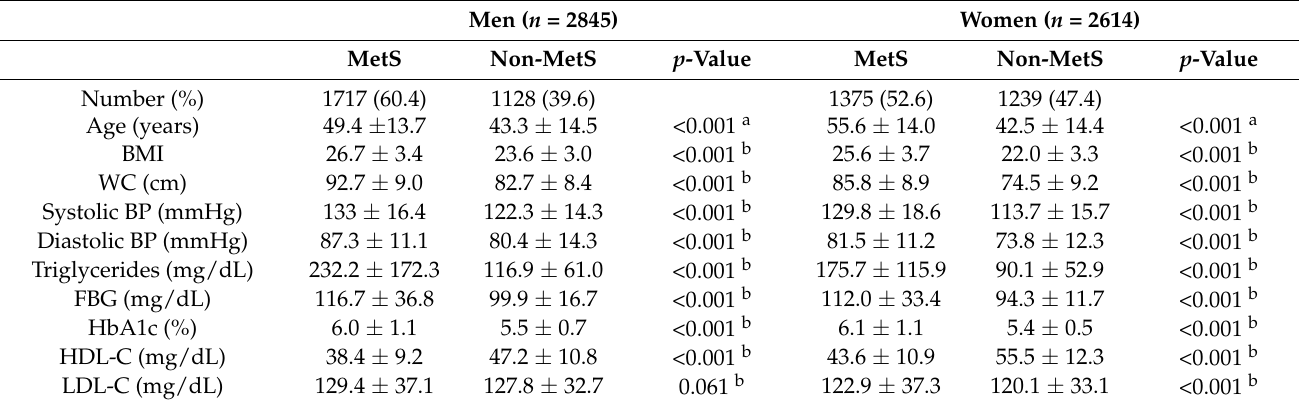
Table 2. Characteristics of participants with MetS and non-MetS.